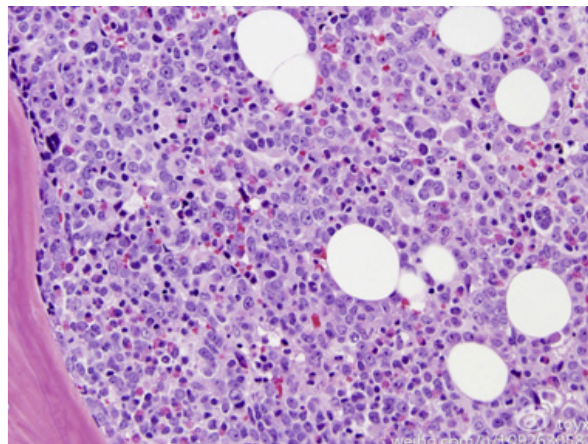
Figure 2. Matrix cell mutations